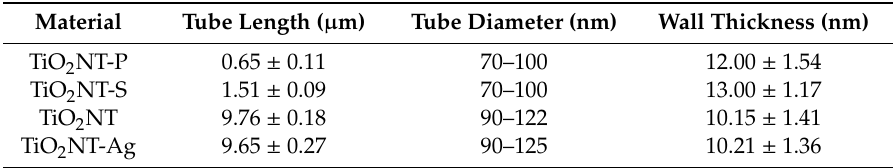
Table 1. Morphological parameters of the di ff erent